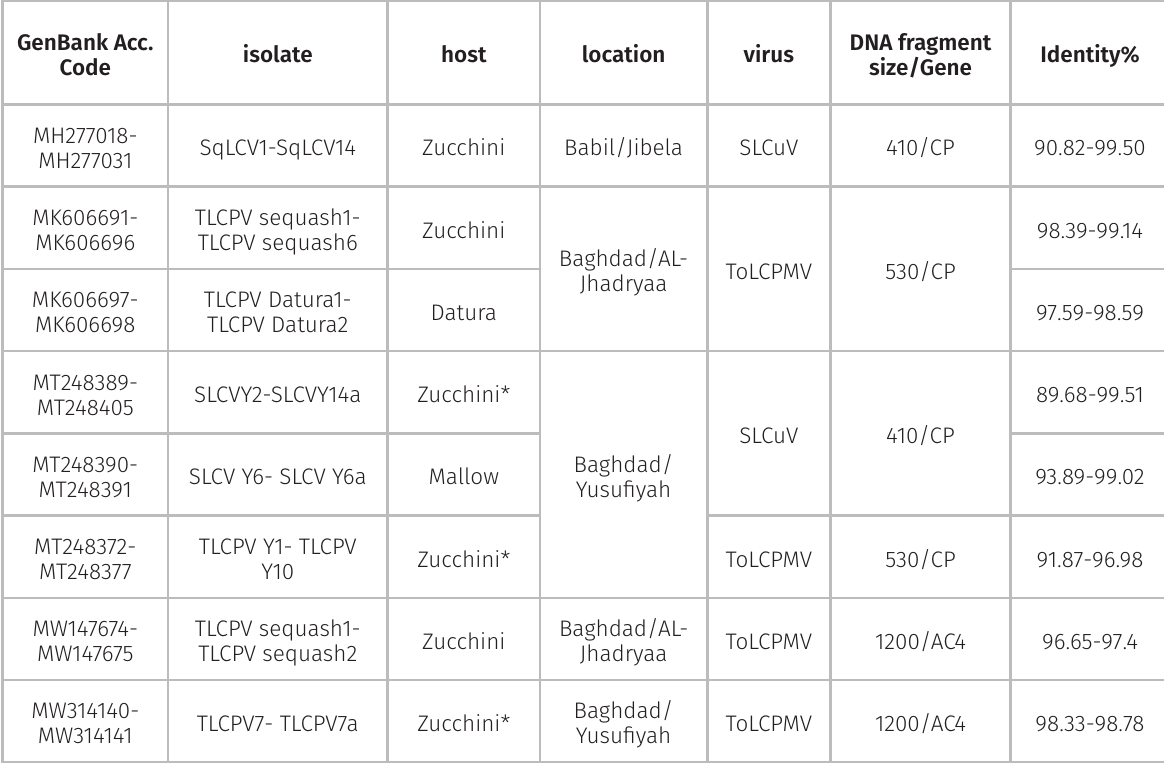
*Samples detected with mixed begomovirus